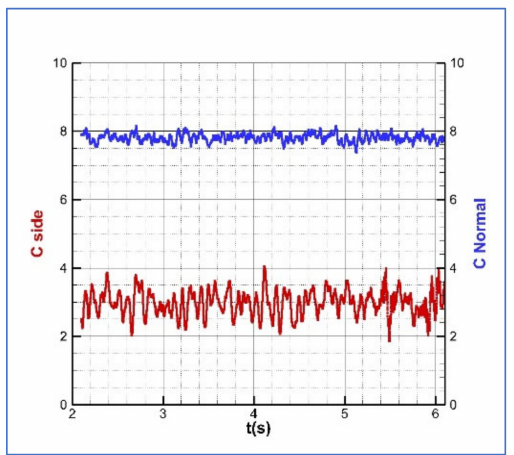
Figure 9. Time history for the side and normal force coefficients at Mach number Ma = 0.2, Reynolds number Re = 2 × 10 6 and angle of attack α = 45 degrees within a time of T = 4 s. ω -based RSM-SAS model. Grid